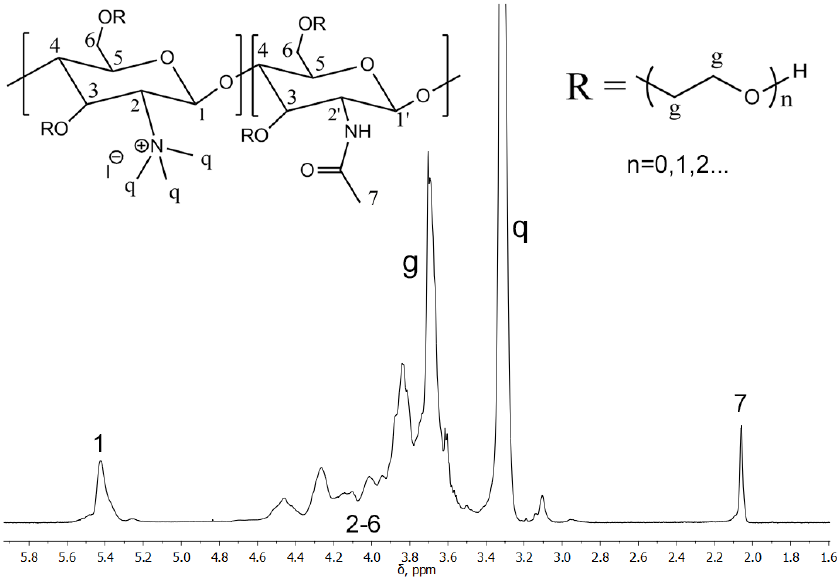
Figure 1. 1 H NMR spectrum of methylglycol-chitosan (MG-CS) (323 К, 400 MHz, D 2 O + DCl).